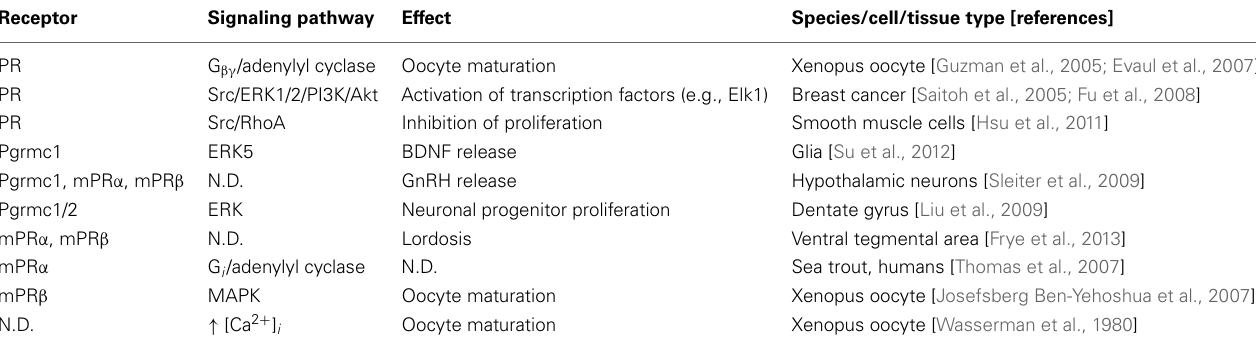
Table 1 | Receptor pharmacology and signaling pathways associated with progesterone-induced non-genomic effects.